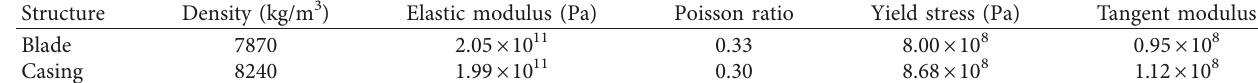
Table 2: Material parameters in the FE model of blade-casing